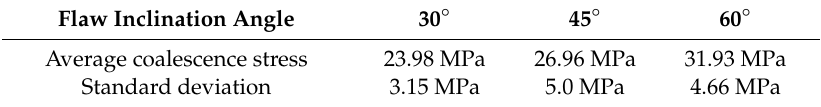
Table 5. Average coalescence stress and standard deviation with respect to the flaw inclination angles.